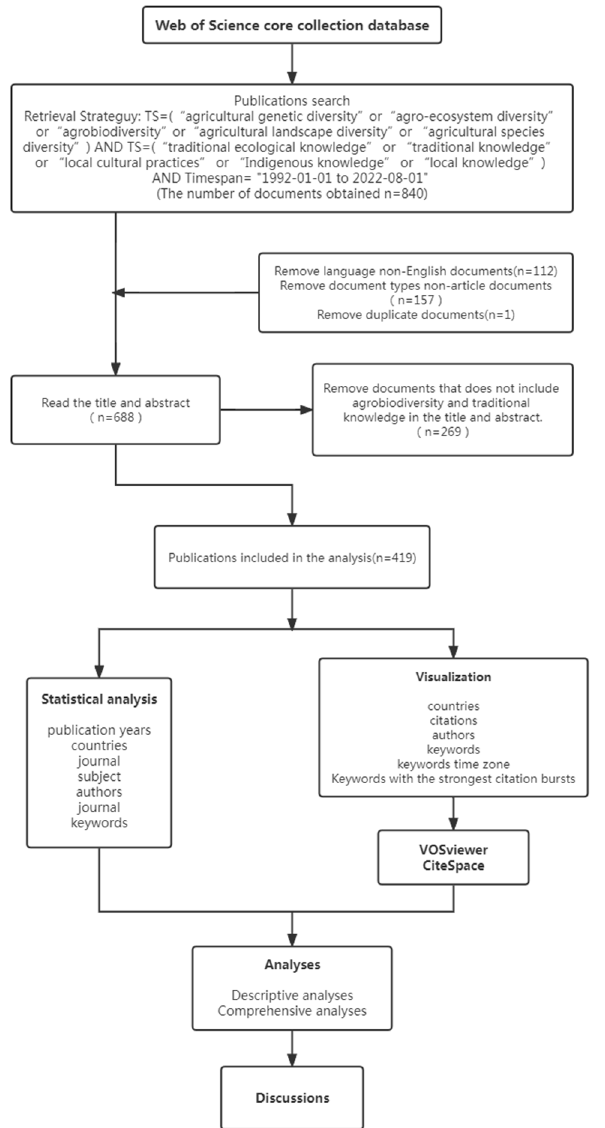
Figure 1. General flowchart of bibliometric analysis.